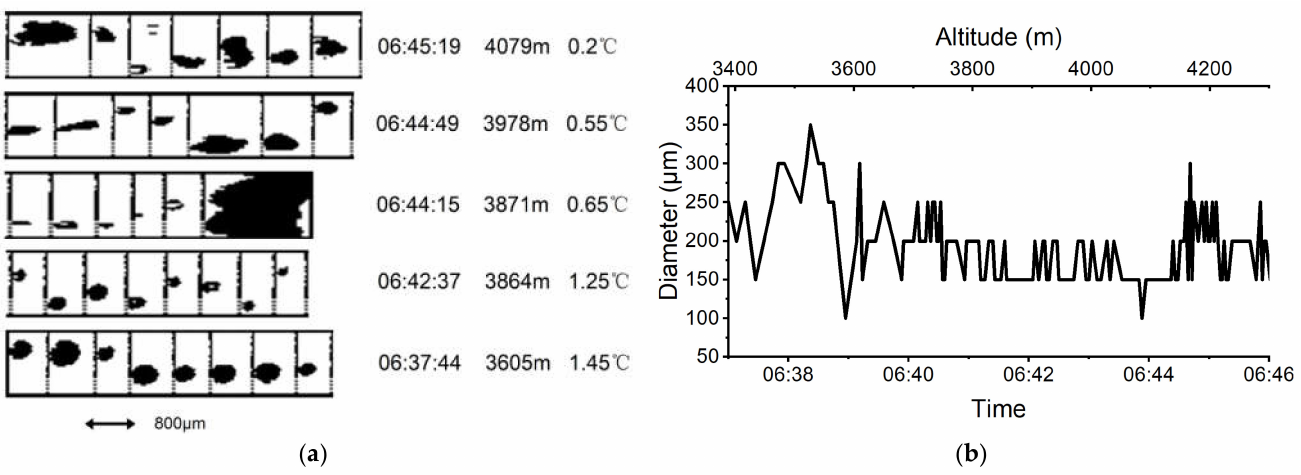
Figure 8. Measurements of the 2D-C probe of ( a ) particle images and ( b ) average diameter in the melting